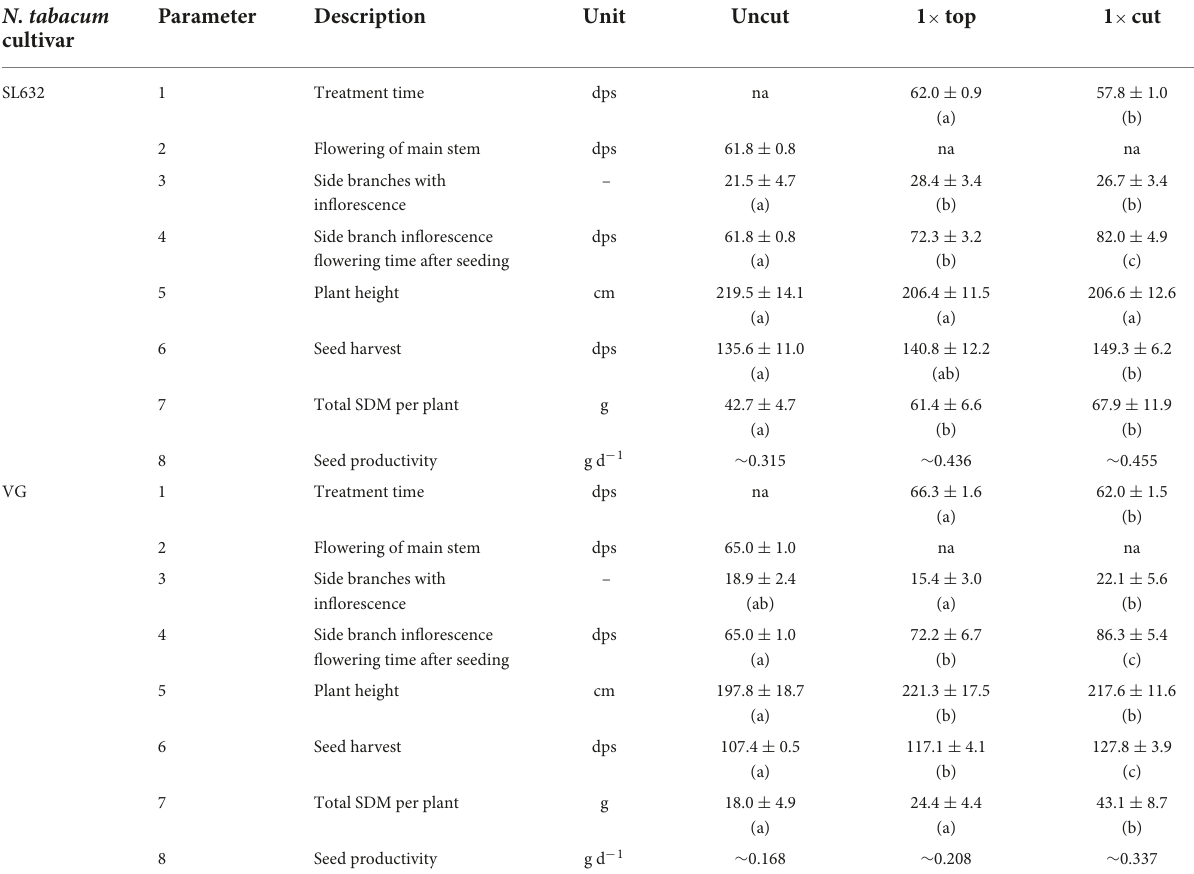
TABLE 1 Plant traits of N. tabacum SL632 and VG under different cultivation strategies in the greenhouse. N.